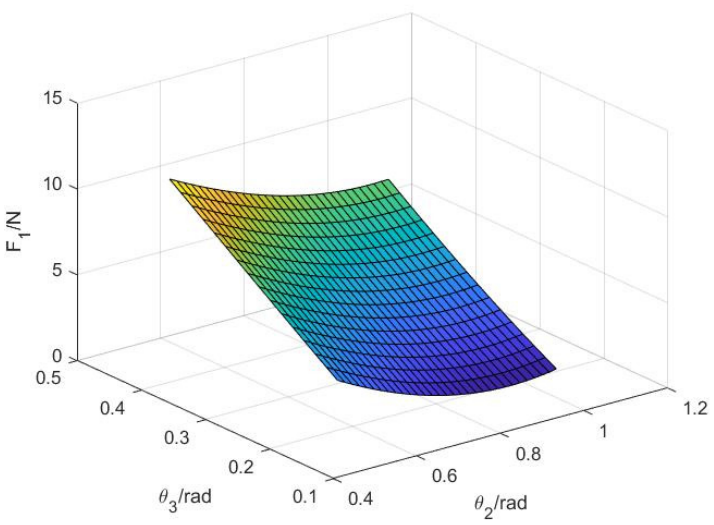
Figure 10. The functional relationship between variables θ 2 , θ 3 , and F 1